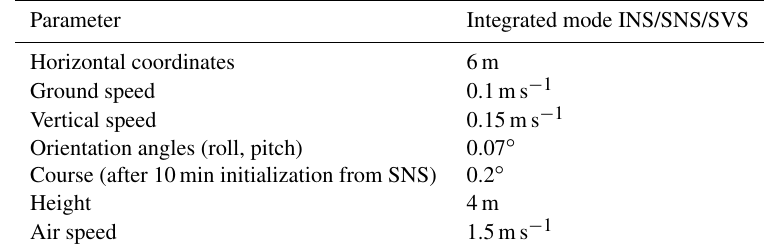
Table 4. Accuracy characteristics.